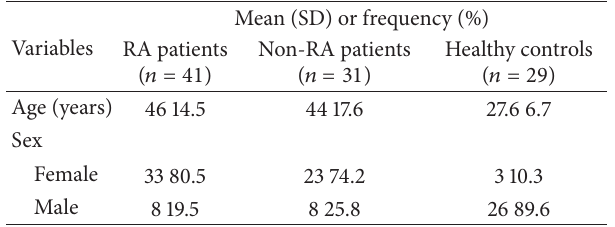
Table 1: Demographic characteristics of the study population.